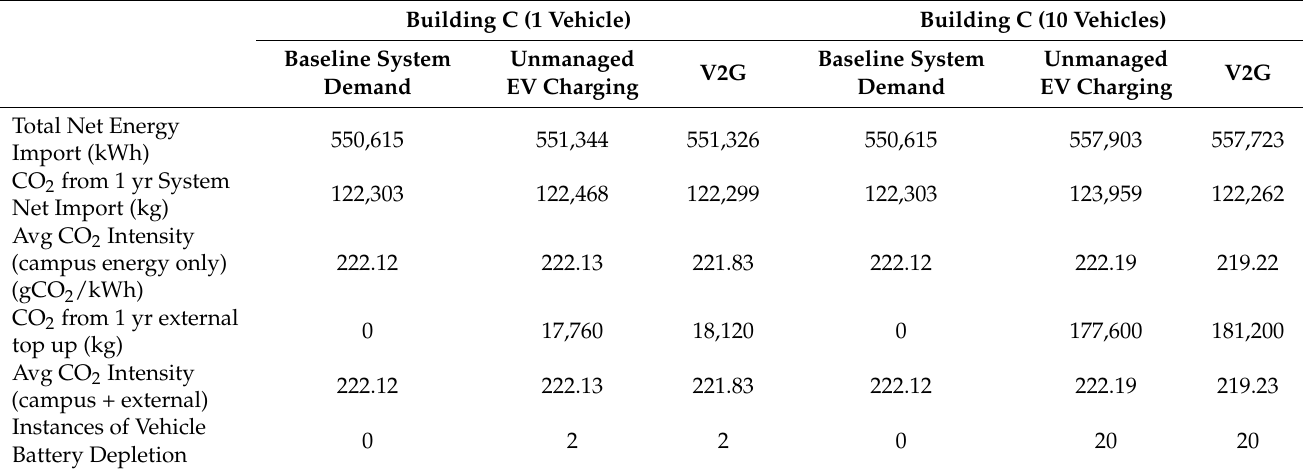
Table 13. Simulated CO 2 emissions of Building